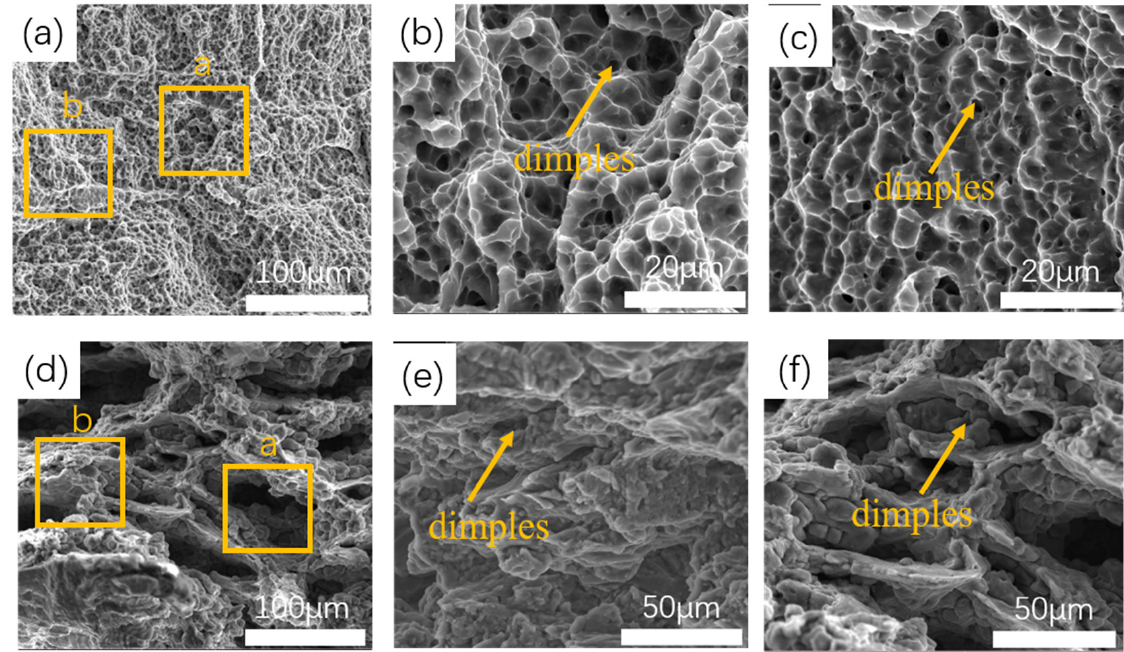
Figure 7. Scanning electron fractographic showing spherical dimples characteristic of ductile fracture resulting from uniaxial tensile loading. ( a ) The fracture morphology of the initial material at 400 °C. ( b , c ) High magnification image of the square insets in Figure 5a. ( d ) The fracture morphology of the heat-treated specimen at 400 °C. ( e , f ) High magnification image of the square insets in Figure 5d.